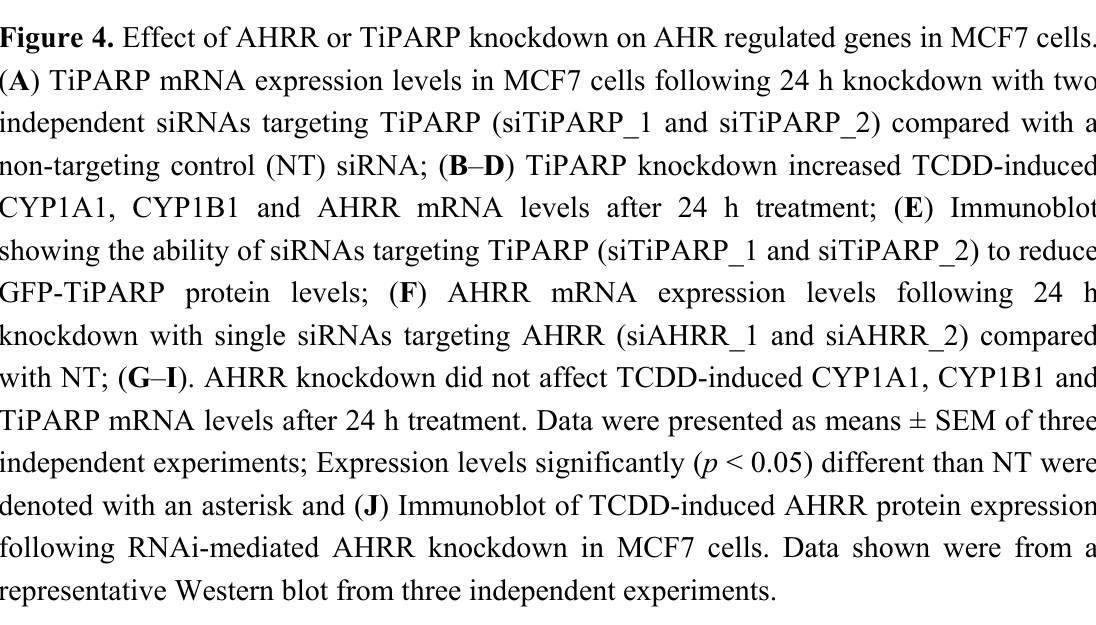
Figure 4. Effect of AHRR or TiPARP knockdown on AHR regulated genes in MCF7